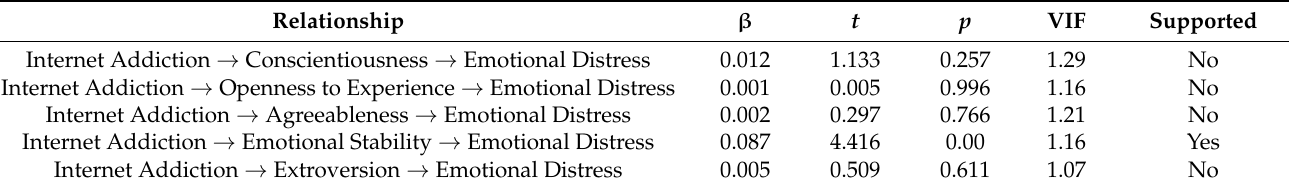
Table 5. Results of indirect